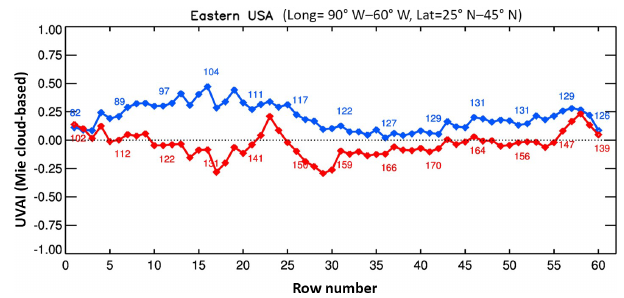
Figure 10. As in Fig. 9 for UVAI calculated with a modified algo- rithm that explicitly accounts for cloud scattering